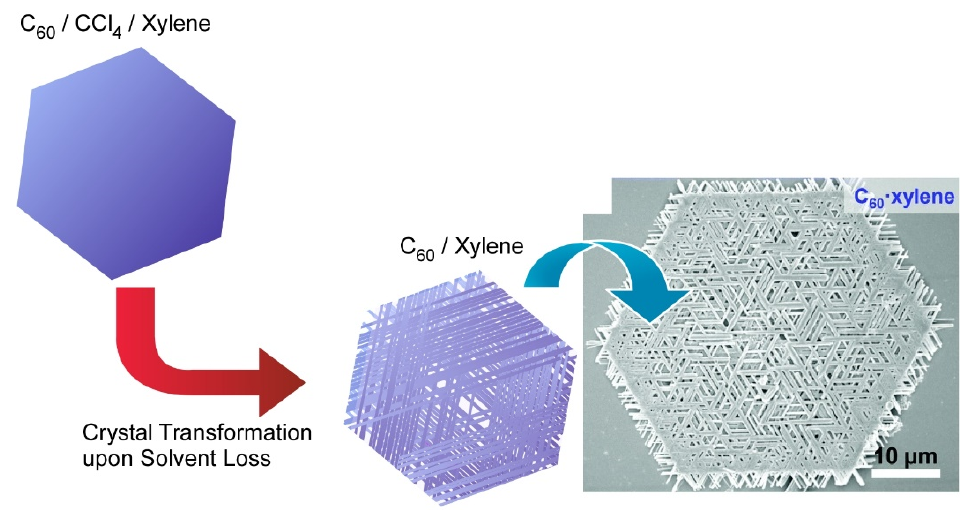
Figure 4. Crystal transformation strategy to transform two-dimensional C 60 microplates to nano- meshes made of ordered nanorods. Reprinted with permission from [113]. Copyright 2019 Royal Society of Chemistry.